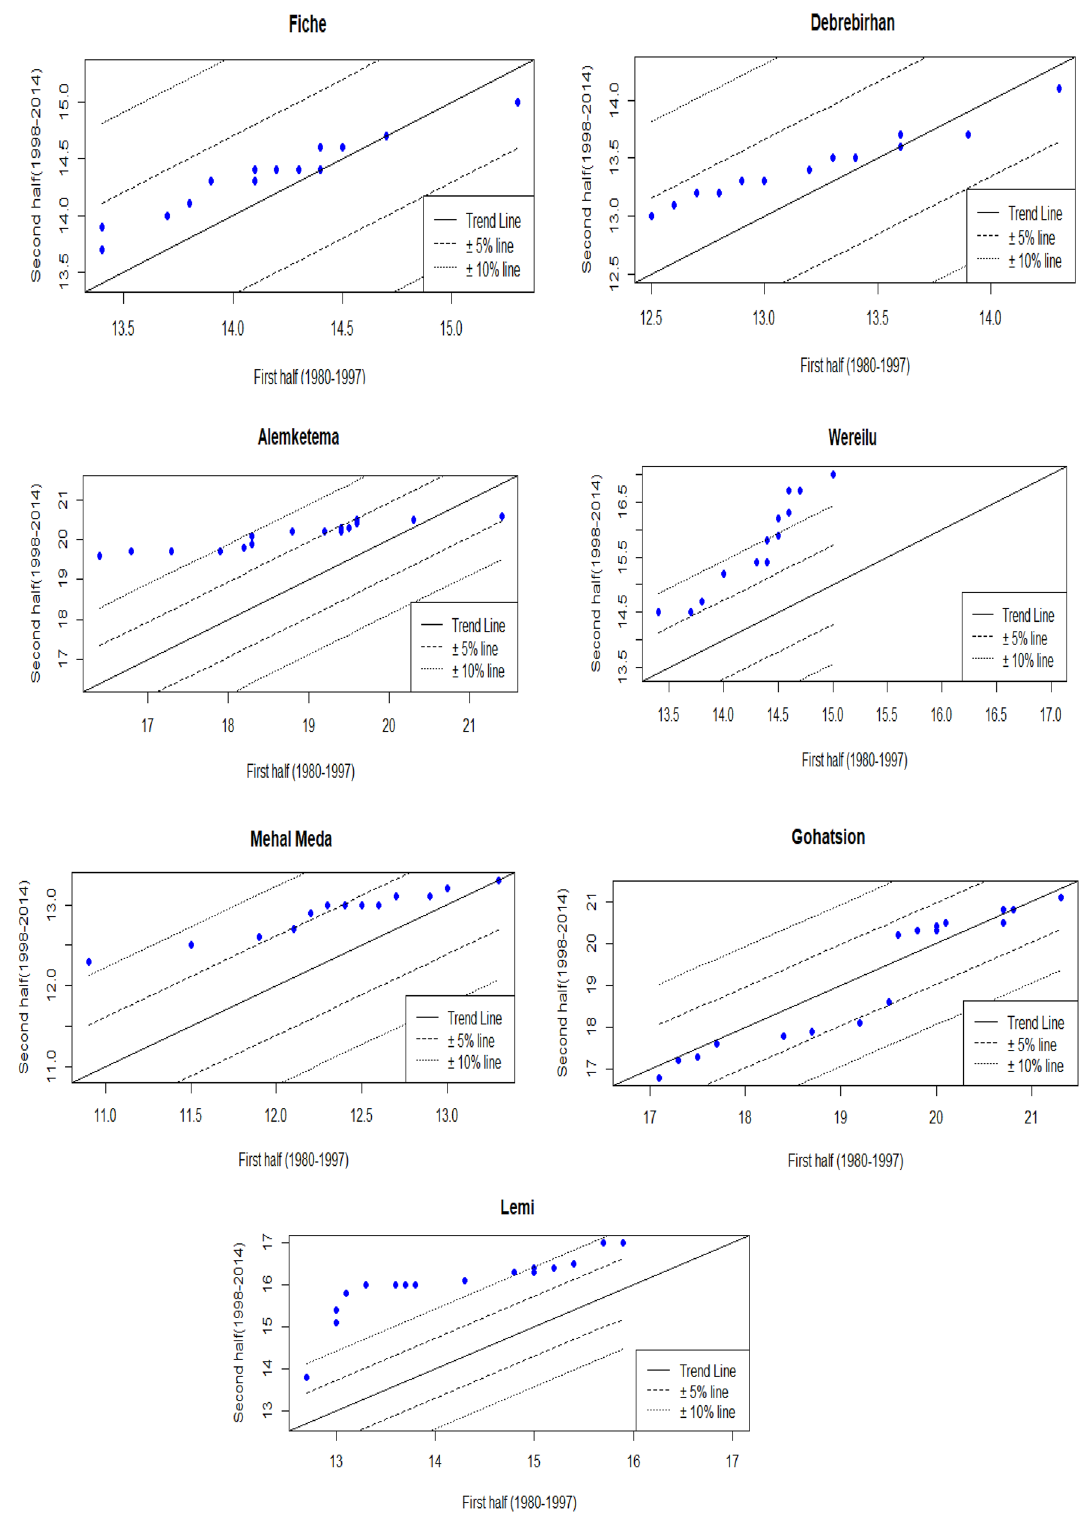
Fig. 3 Innovative trend analysis graph for temperature: The path of red dots along the trend line is indicating the increasing /decreasing trend of temperature between 1980 and